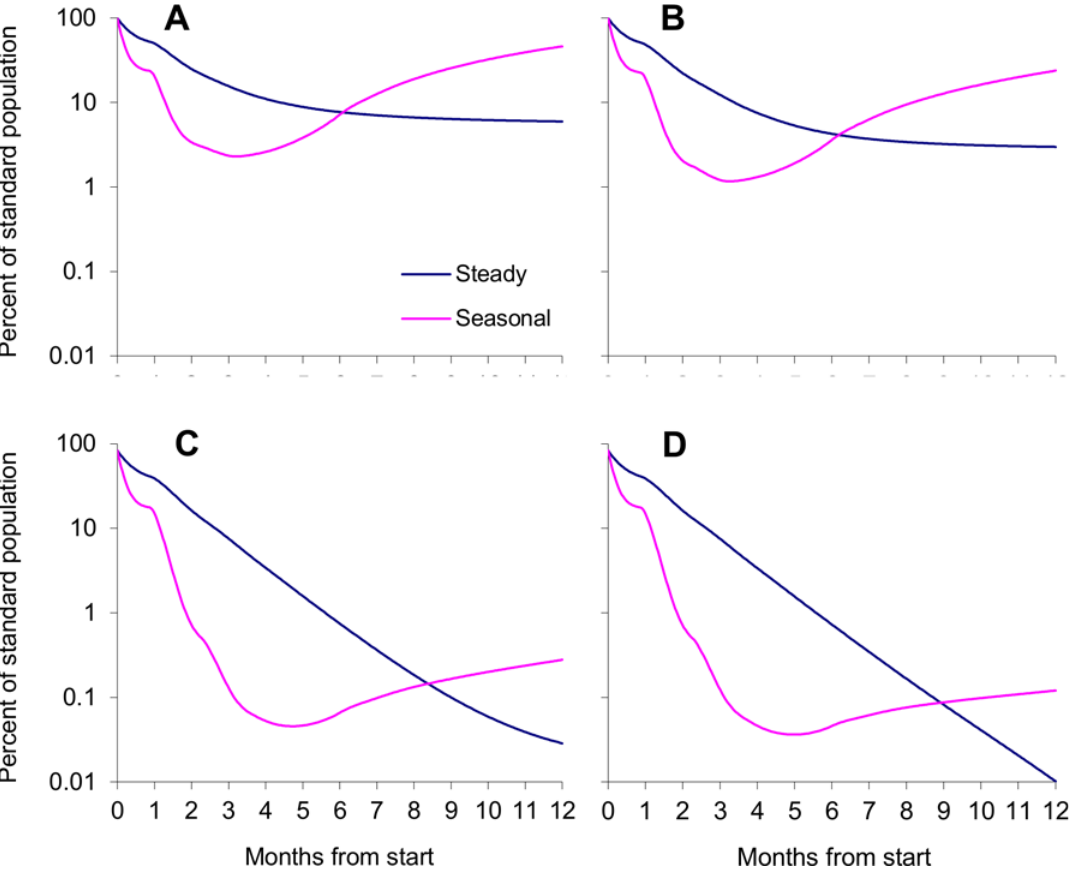
Fig 6. Population density at various times after starting steady or seasonal control in good non-isolated habitat, with various habitats in the invasion source. Average population density of tsetse in the treated area within 10km of the invasion front(s), as a percent of the standard density, at various times after the start of normal steady control or standard seasonal control, in an area where the invasion source was all good habit adjacent to a treated area spanning 10km (A) and > 40km (B), or where the treated area spanned > 40km of good habitat and the invasion source had a 10km (C) and > 40km (D) segment of poor habitat type NS. For normal steady control the daily kill rate was fixed at 5%. For standard seasonal control the rate was 15% for the first three months, followed by a linear decline to zero in the next three months. The horizontal dotted line shows the 90% level control.